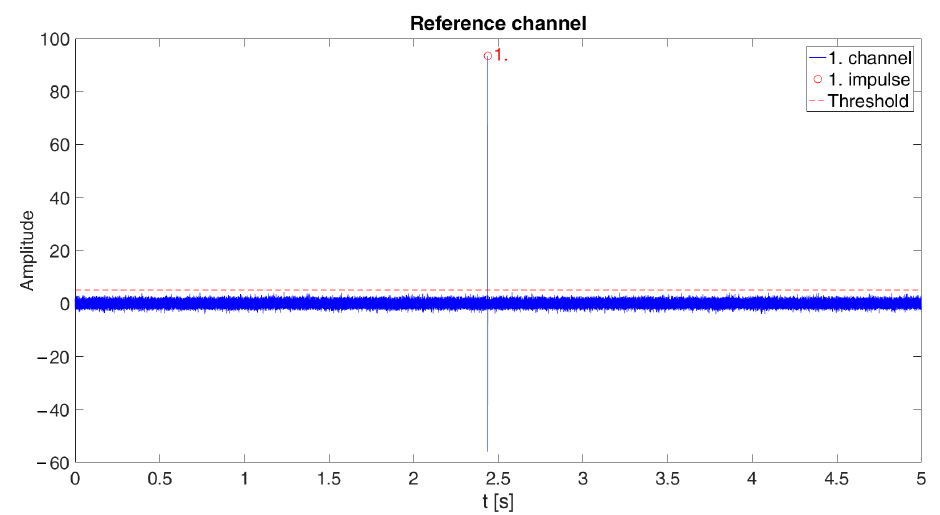
Figure 3. The acquired signal with one acoustic source in the reference channel.